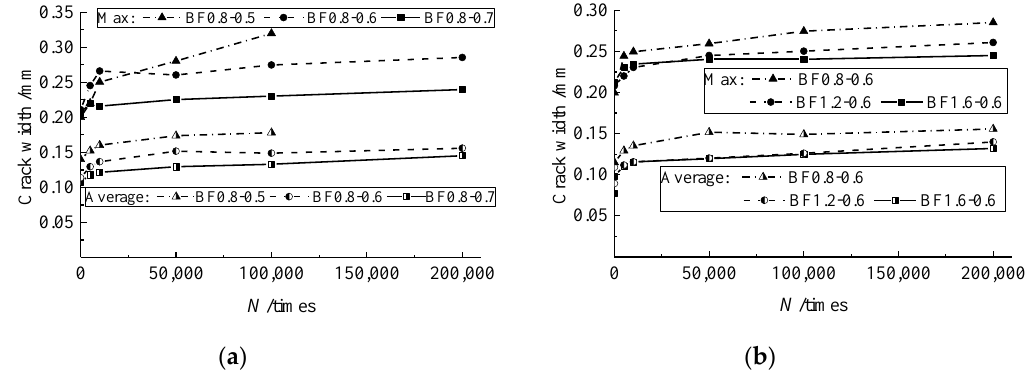
Figure 4. Changes of crack width affected by: ( a ) α h ; and ( b ) v f .